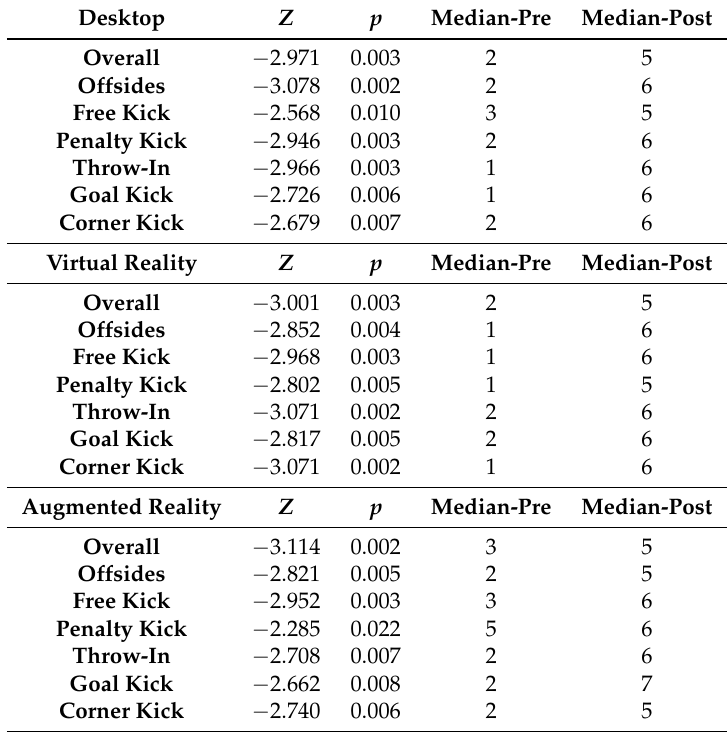
Table 4. Statistical results from the Wilcoxon Signed Rank Test comparing users’ self perception of soccer knowledge before using the system to their perceived increase in knowledge following use of the system. Statistical significance is indicated by bold text.